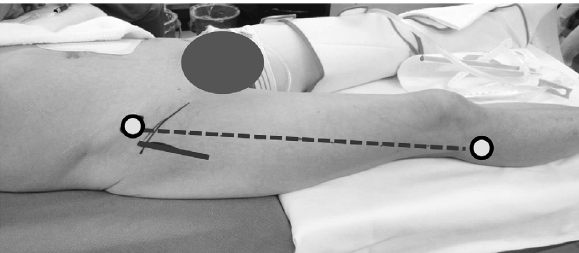
Figure 2. The skin incision of DAA was made from a site two- finger-breath distal and two-finger-breath lateral to the anterior superior iliac spine. It was parallel to a line drawn from the anterior superior iliac spine to the fibular head, and the incision length was about 10